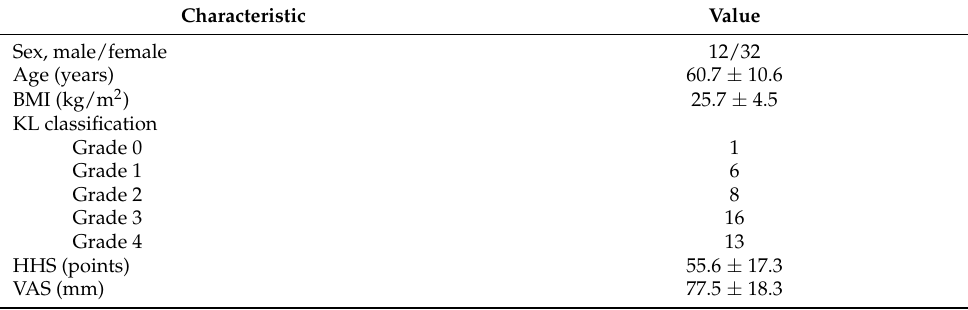
Table 1. Patients’ clinical assessment data (n = 44).